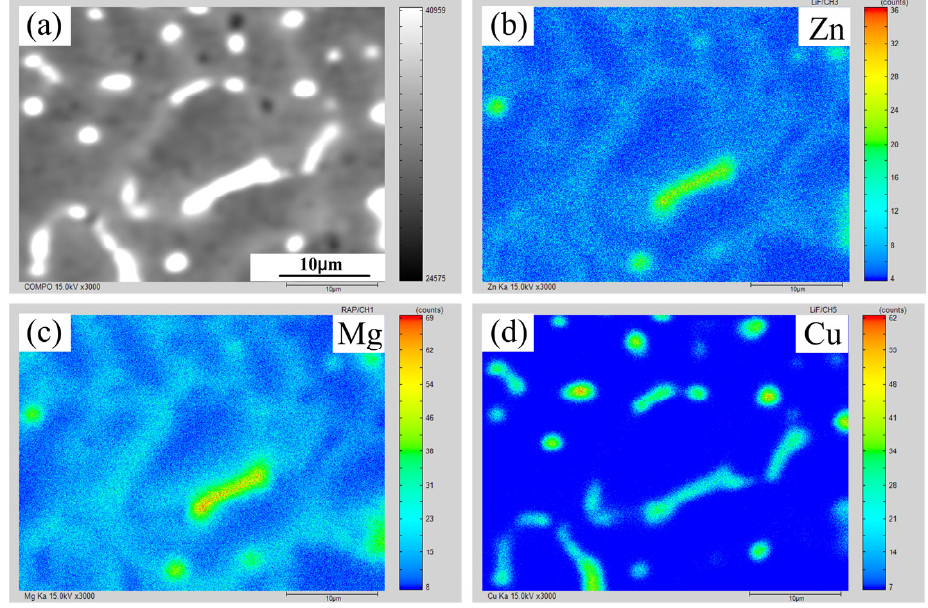
Figure 8. Elemental distribution of the weld under CMT+P arc mode: ( a ) secondary electron image; ( b ) distribution of Zn; ( c ) distribution of Mg; ( d ) distribution of Cu.